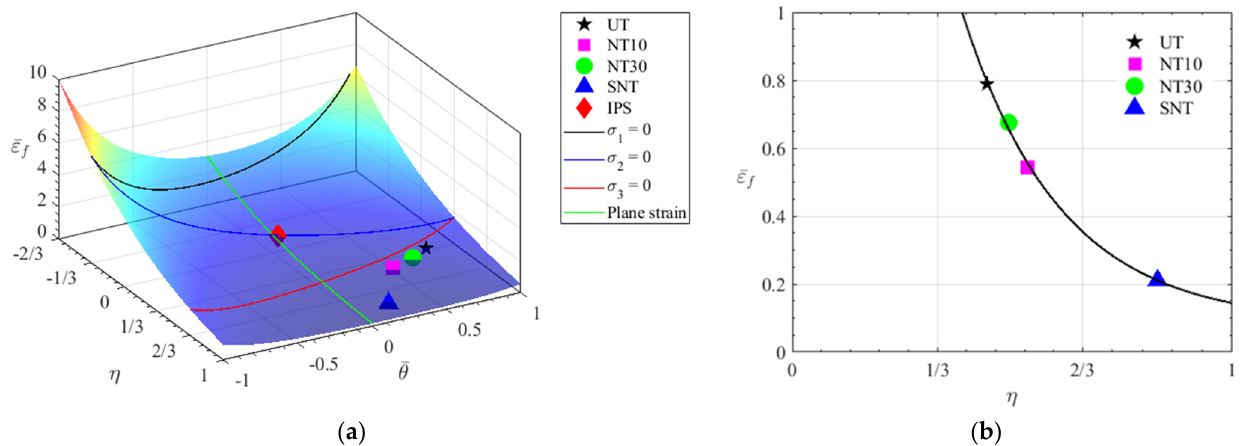
Figure 8. Fracture surface (locus) of 3.0 wt% silicon steel ( a ) 3D; ( b ) 2D.